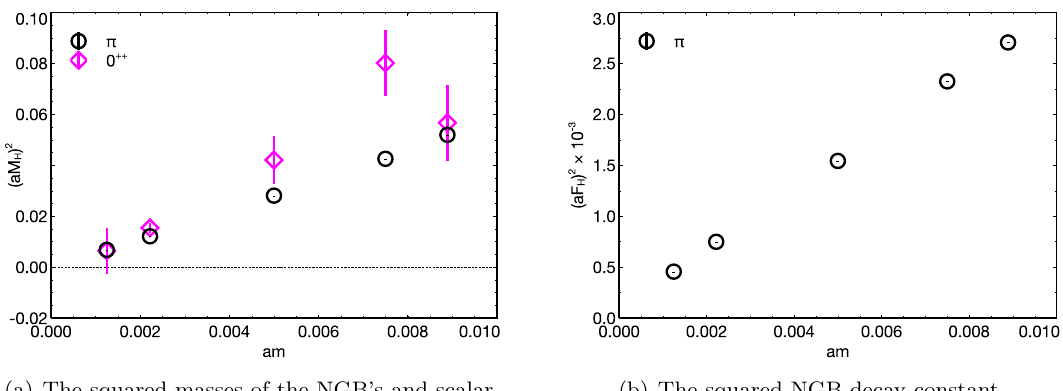
Figure 1 . Data from the LSD collaboration [15, 27]. Error bars represent only the statistical uncertainty in the data. The lattice spacing is denoted by the parameter